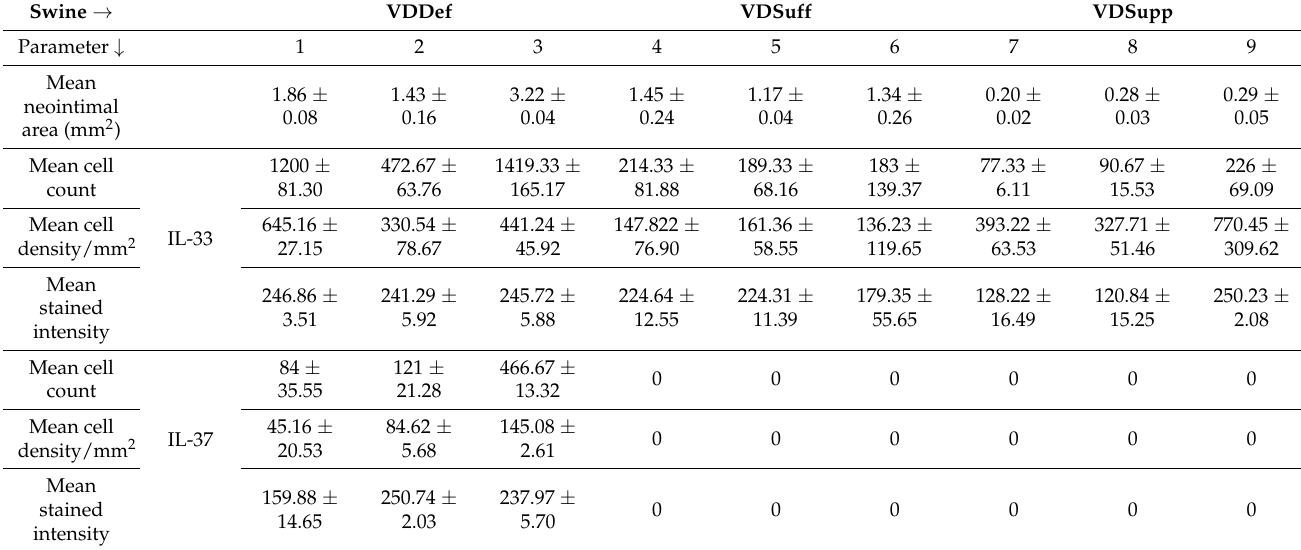
Table 1. Parameters measured in vitamin D deficient (VDDef), sufficient (VDSuff), and supplemented (VDSupp) Yucatan microswine. All the data are presented as mean ± S.D (n =